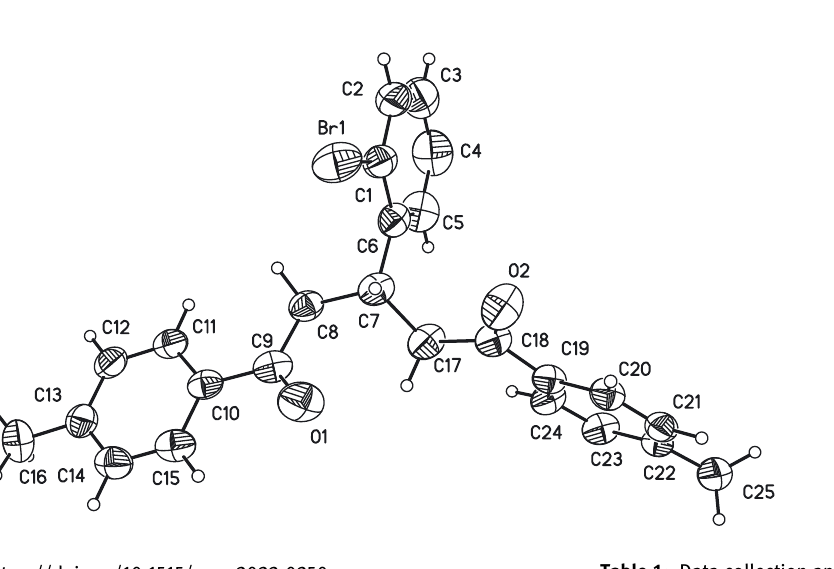
Table  : Data collection and